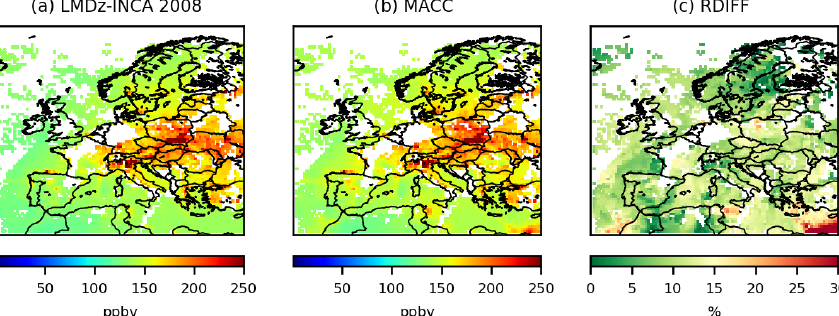
Figure 4. Mean CO surface concentrations from 1 to 7 March 2015 simulated by CHIMERE using for initial and boundary conditions, (a) the climatological values from the LMDZ-INCA global model; (b) the climatological values from a MACC reanalysis, in ppbv; and (c) the relative differences between these two simulations , in %, at the 0.5 ◦ × 0.5 ◦ grid-cell